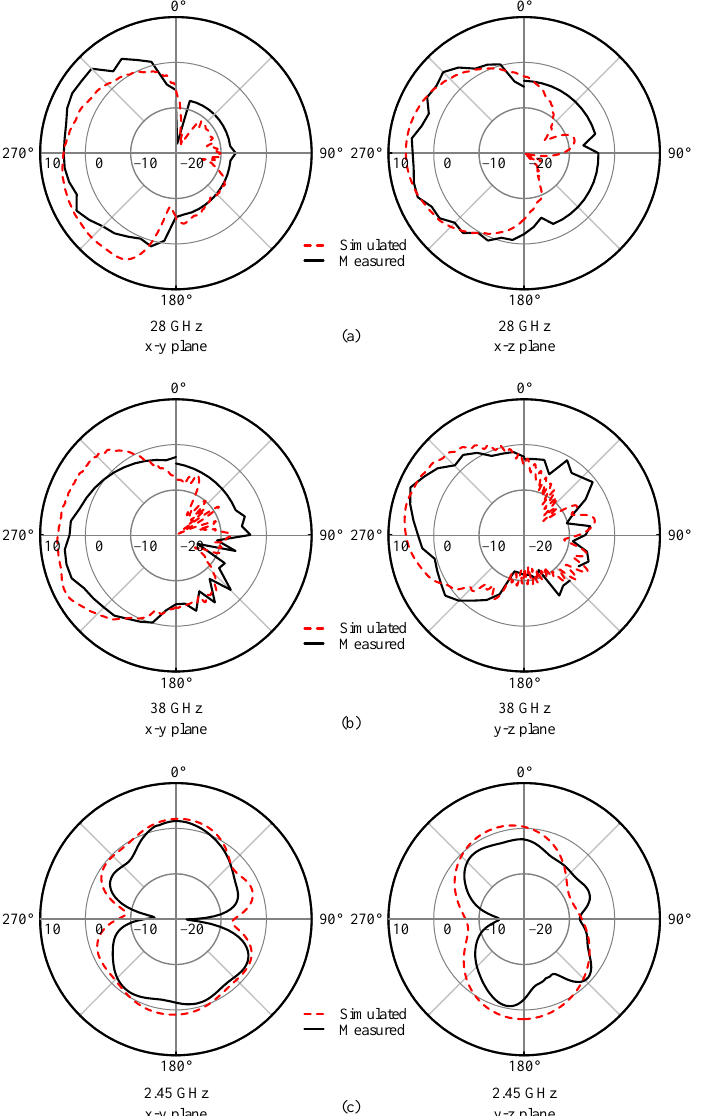
Figure 10. Radiation patterns for ( a ) the 28 GHz unit element, ( b ) 38 GHz unit element, and ( c ) 2.45 GHz loop antenna.